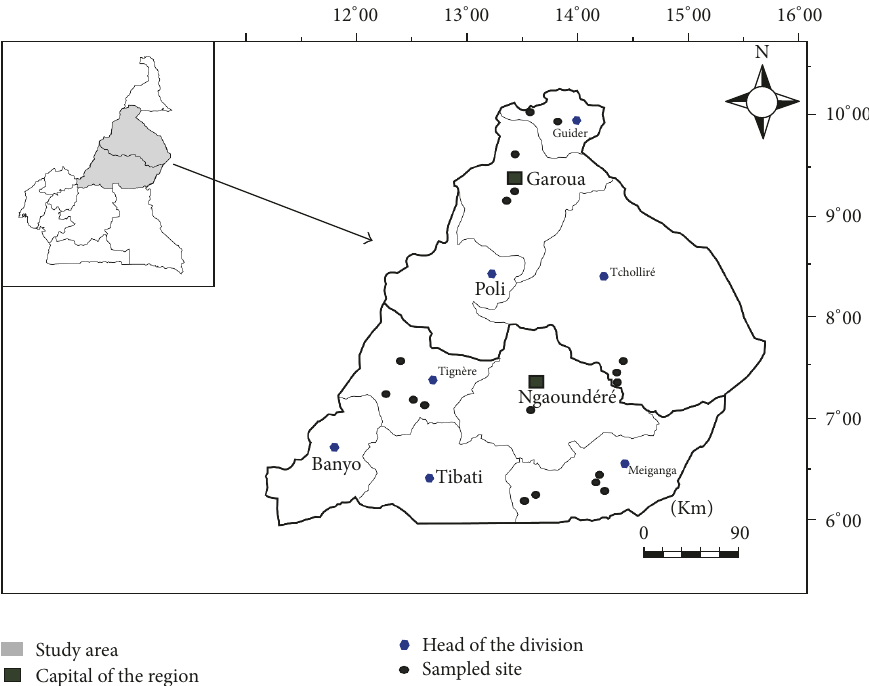
Figure 1: Map showing study areas in the North and Adamawa Regions of